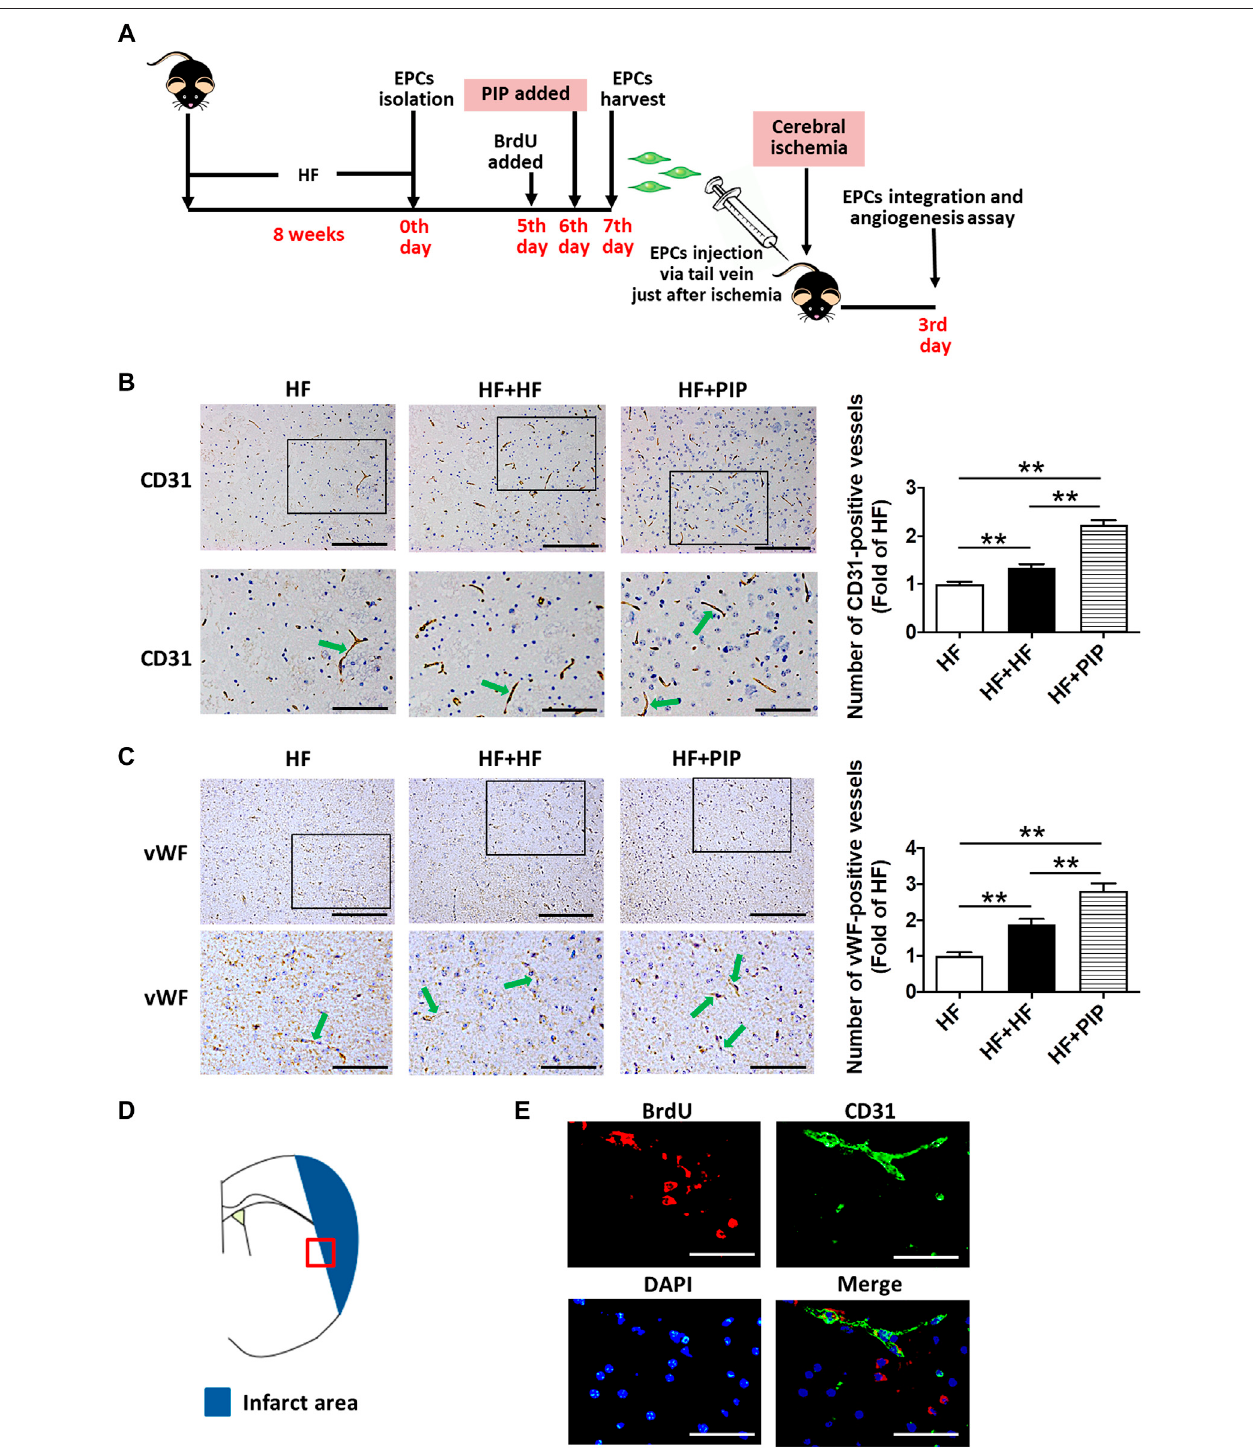
FIGURE 6 | Incubation with piperlongumine increased the therapeutic effect of EPC from HFD-fed mice on angiogenesis promotion in HFD-fed mice. (A) , Surgical protocols: Male C57BL/6 mice (8 weeks) were fed with high-fat rodent chow for 8 weeks. Then, the EPCs were isolated from the HFD-fed mice. On day fi ve of culture, BrdU were added to the media, and new medium supplemented with BrdU was replenished daily until day 7. Piperlongumine (1.0 μ M) was added to EPCs on day 6 for 24 h. EPCs were harvested at the 7 th day and injected into the HFD-fed mice via tail vein just after the middle cerebral artery occlusion (1 × 10 6 EPCs per mice). On day 3 after middle cerebral artery occlusion, the local angiogenesis in ischemic brain were determined. (B) , immunostaining for CD31 shows typical microvessels in the